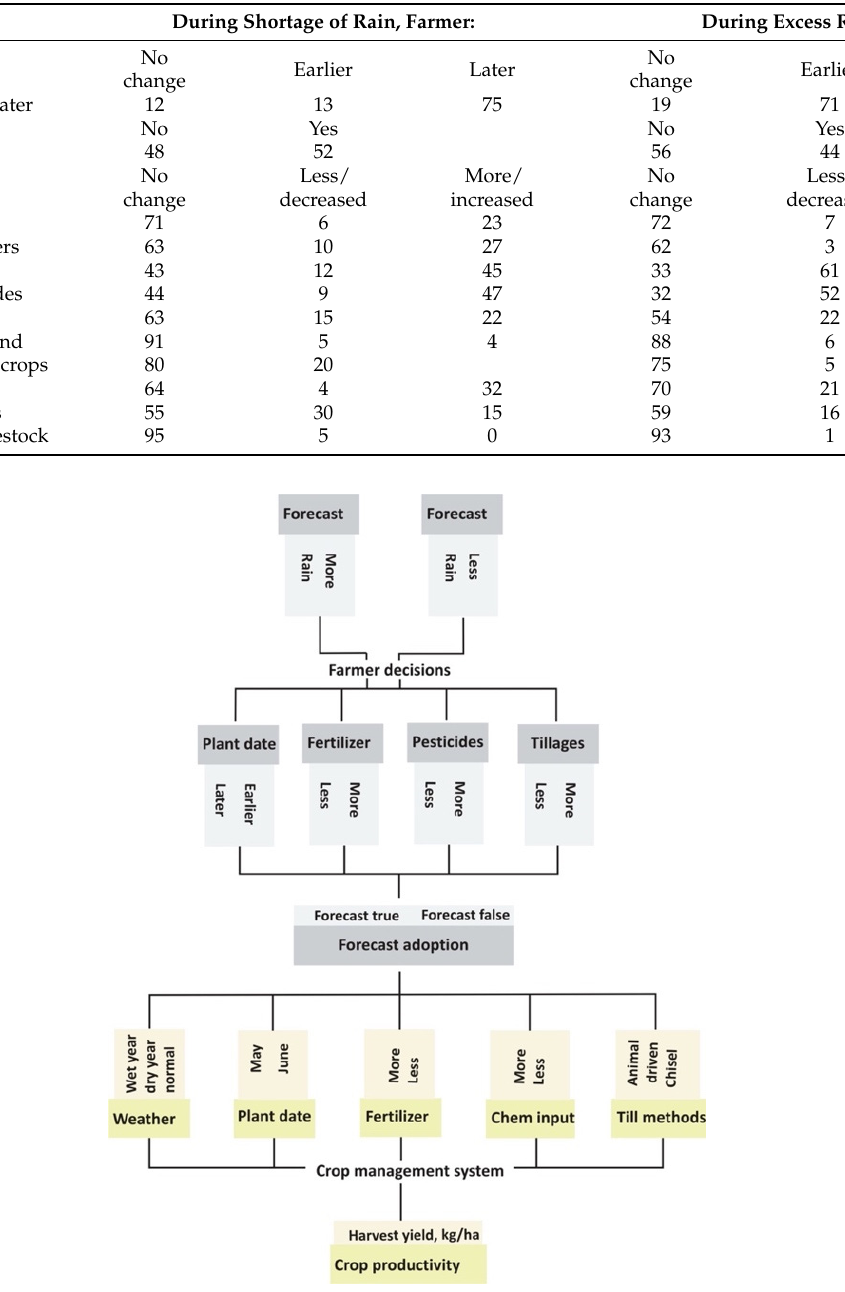
Figure 3. Project framework to couple ABM and crop productivity programs to study farmers’ decisions on farming activities and agricultural productivities.